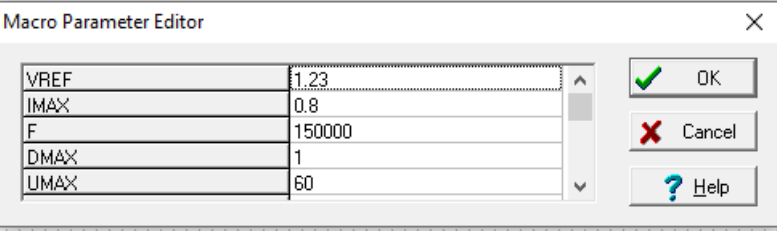
Figure 26. Universal model parameters according to the LM2594HV datasheet. In order to make the simulations more effective, previous parameters ( I sw , V reg-out , I L ,